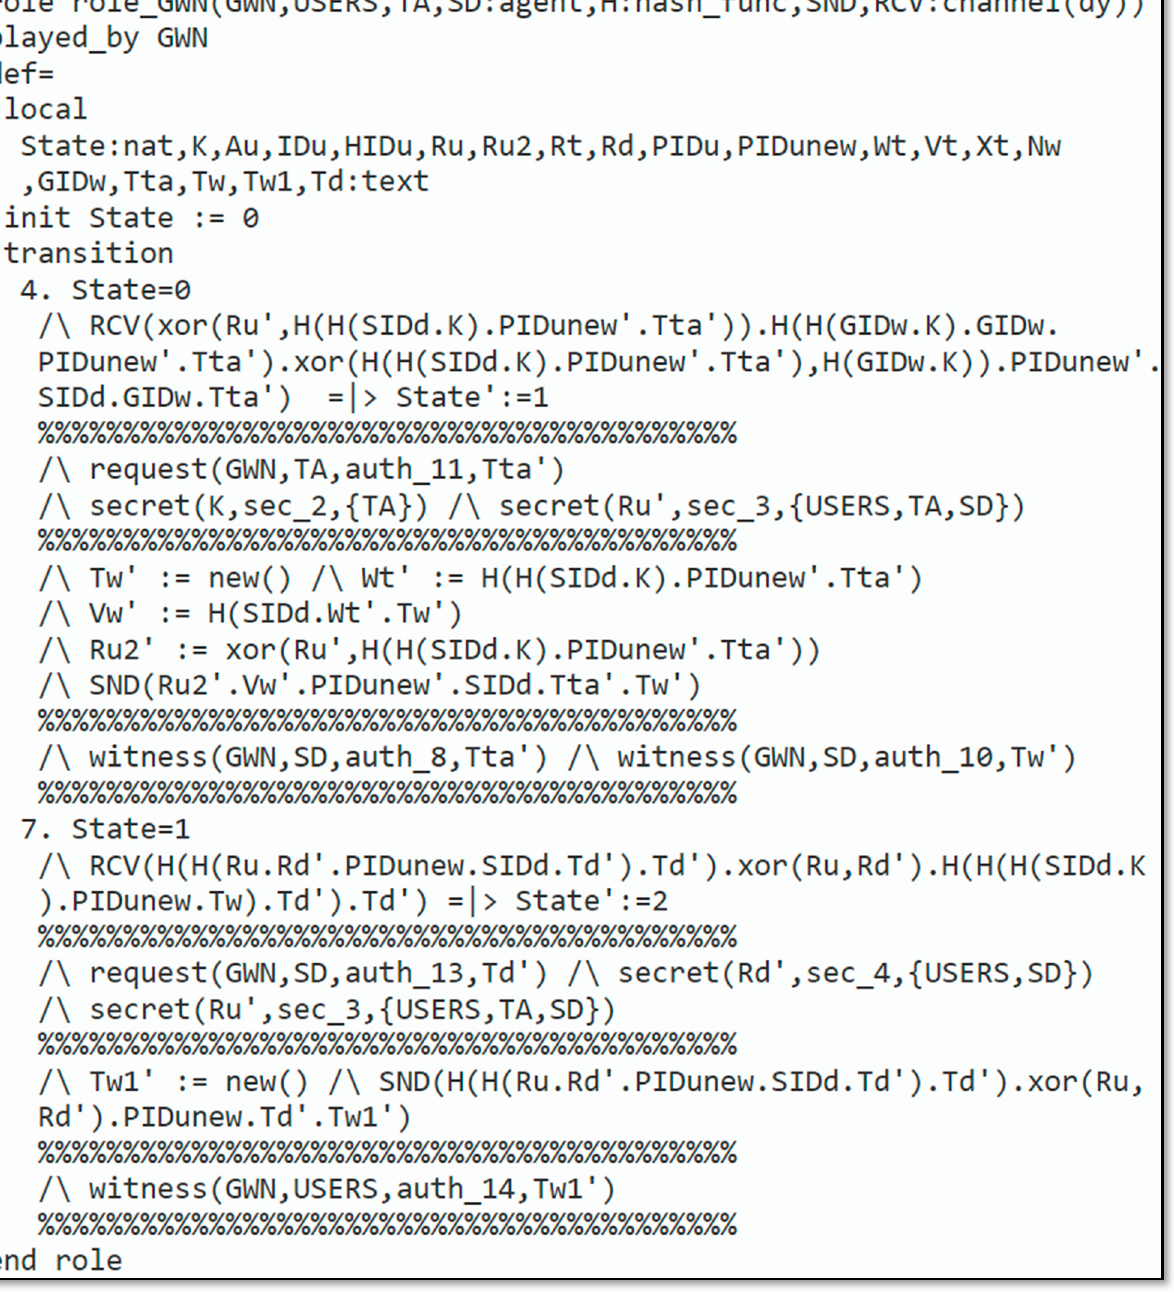
Figure 6. Role specification for GWN.